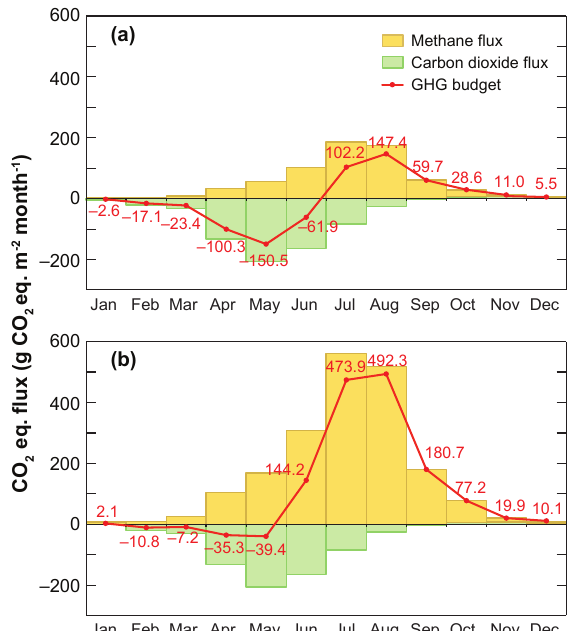
Figure 8. EC-measured monthly CO 2 , CH 4 , and net GHGs fluxes shown as CO 2 eq. totals by using (a) 100-year and (b) 20-year GWPs. Missing data were